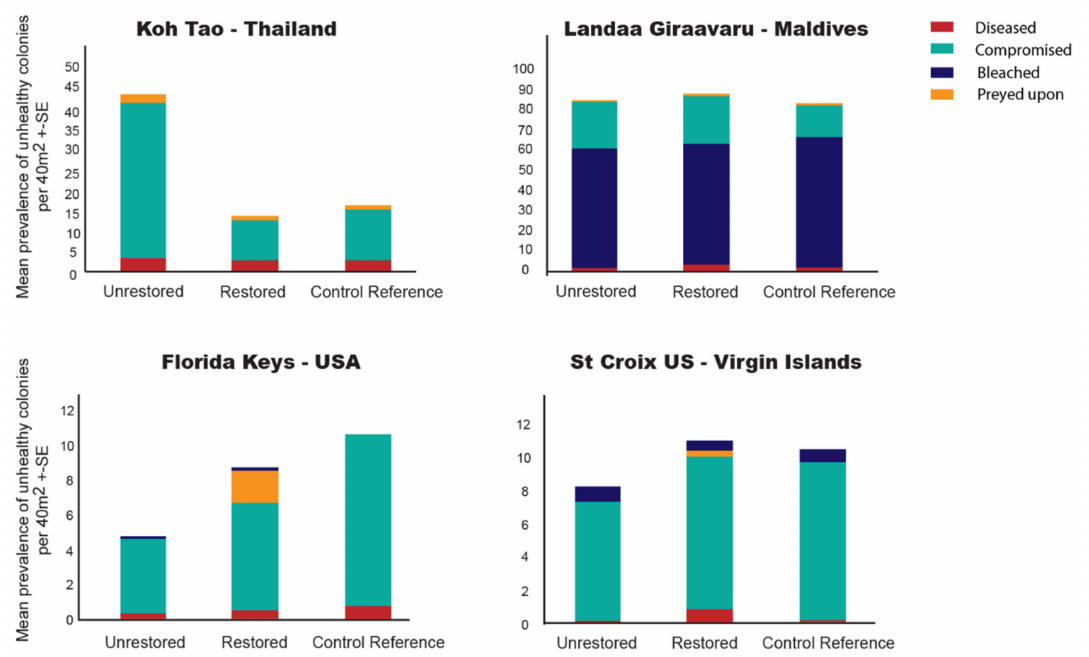
Figure 8. Mean prevalence of corals in four health categories representing unhealthy states (corals with signs of disease, bleaching, predation, or other signs of compromised health) per 40-m 2 belt transect compared among treatments (unrestored, restored, control reference sites) at each of the four locations. n = 9 transects per treatment in Koh Tao, Landaa Giraavaru, and the Florida Keys; In St Croix, n = 8 transects for unrestored and restored treatments, n = 6 transects for the control reference